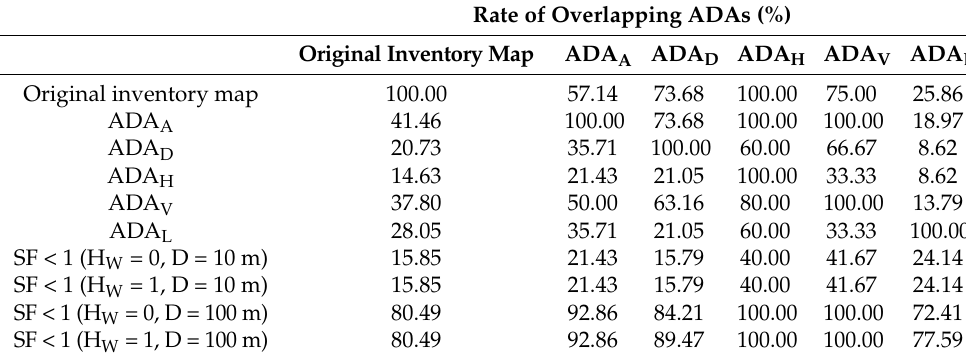
Table 6. Confusion matrix to analyze the percentage overlap between